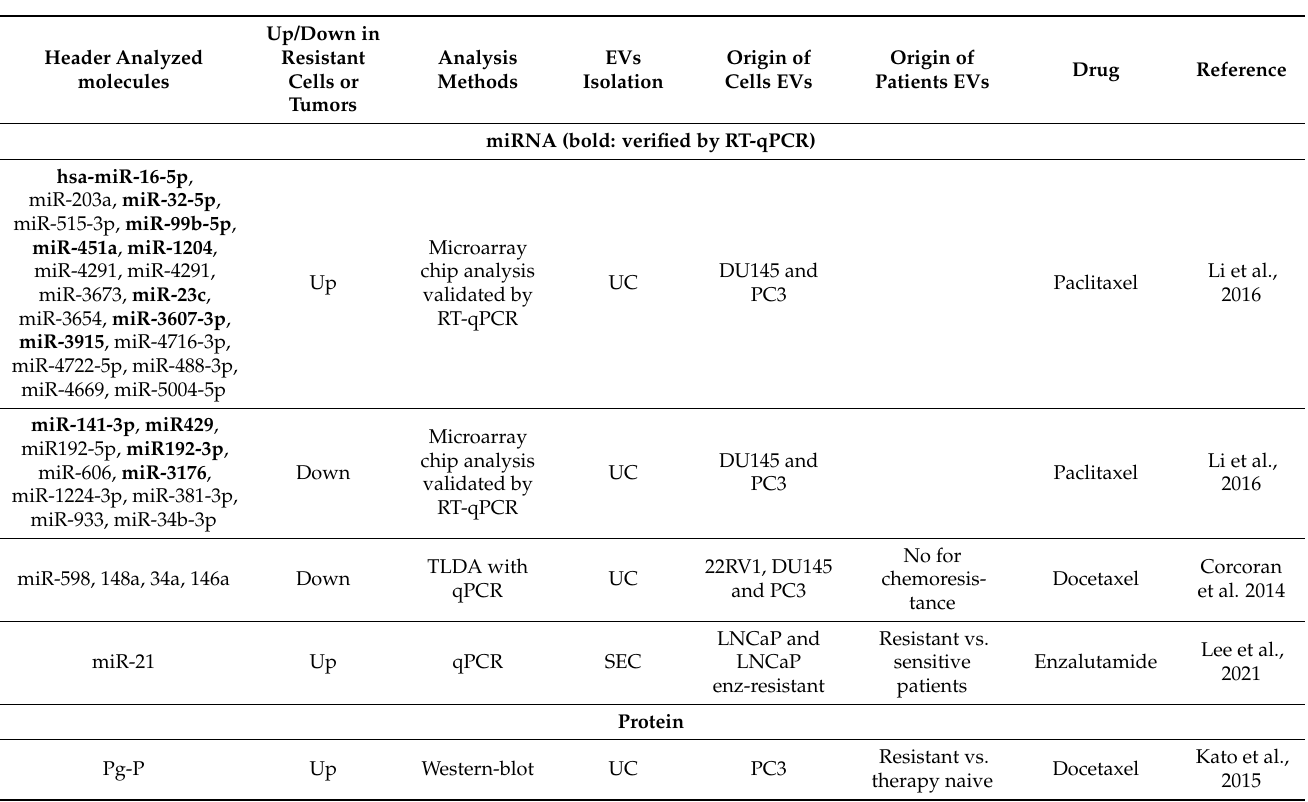
Table 1. List of biomarkers from EVs studied to be predictive of resistance/sensitivity to advanced PCa therapies. In bold miRNA were verified by RT-qPCR. Abbreviations: for EVs isolation, UC = Ultracentrifugation, SEC = Size Exclusion Chromatography, UF = Ultrafiltration; for analysis methods, ddPCR = droplet digital PCR, TLDA = Taqman Low Density Array. Header Analyzed